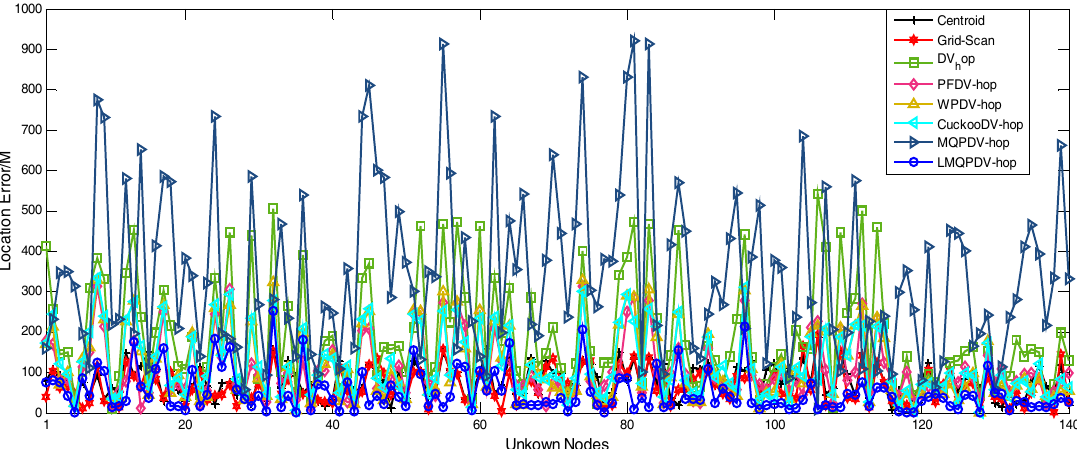
Figure 22. The location error of LMQPDV-hop when the anchor proportion was 30% and R = 250 for WSN#2.